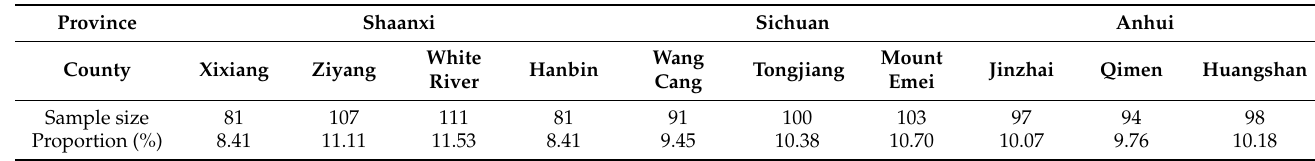
Table 1. Research area and sample